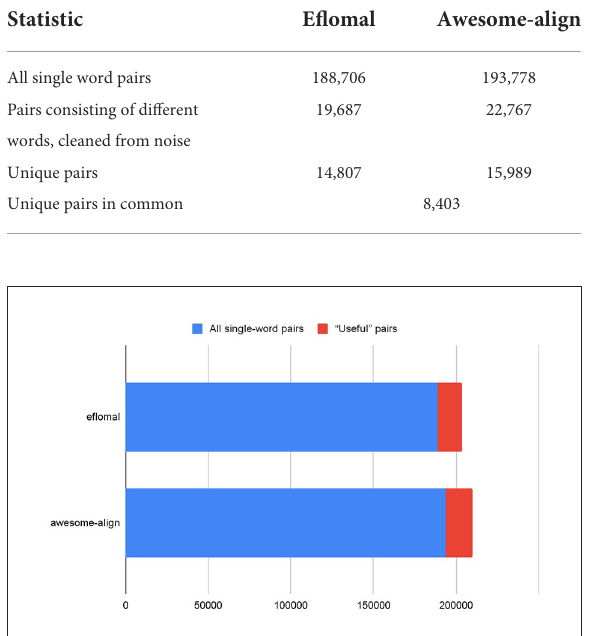
FIGURE1 The percentage of “useful” pairs among all